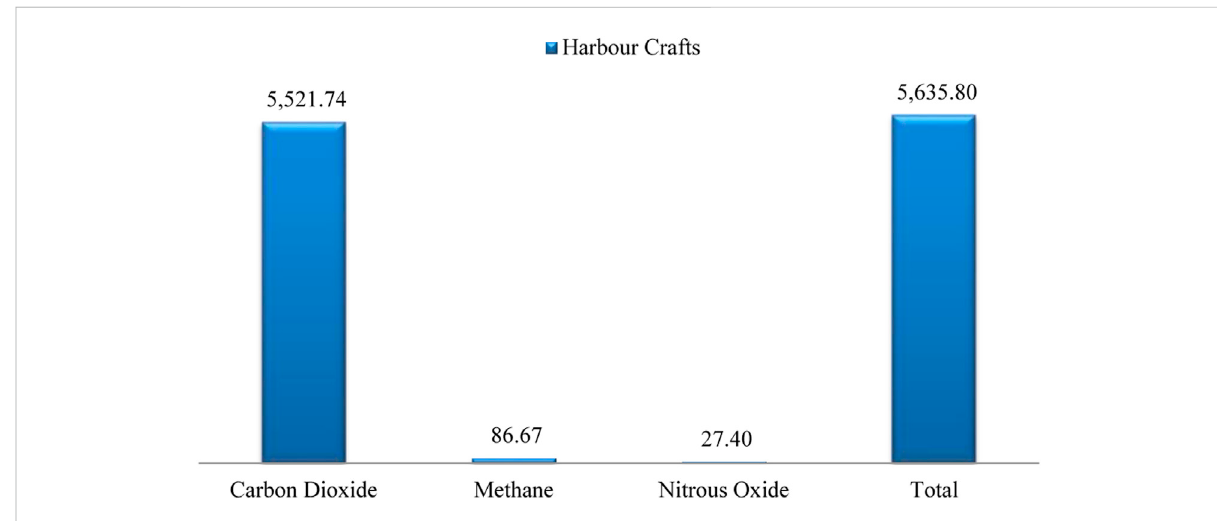
FIGURE 11 Total annual GHG emissions (tonnes CO 2 e/annum) from harbour crafts of